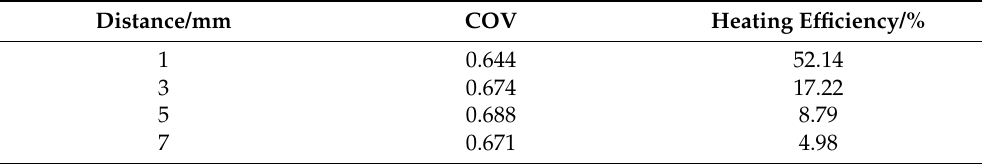
Figure 13. The electric field distribution in the cross-section of z = 0.4 mm. Table 5. The heating performance with different distances between the ridges.